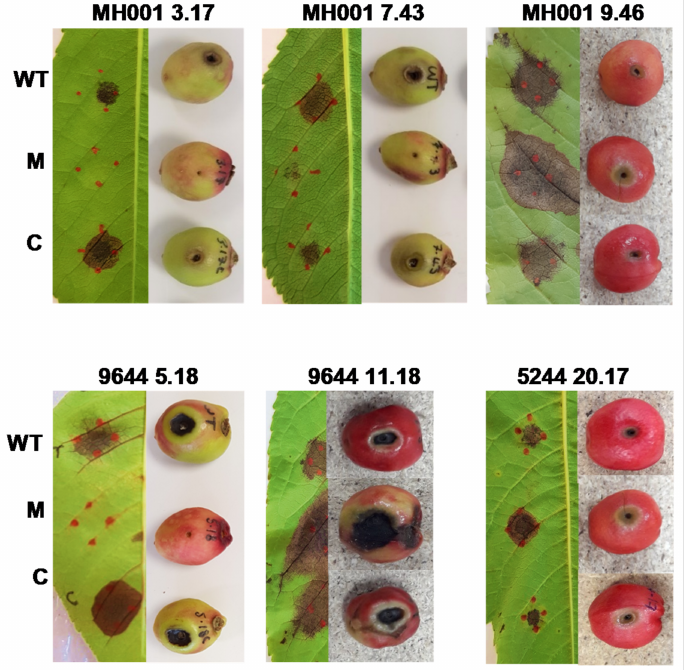
Figure 4. Complementation of selected Pseudomonas syringae transposon disruption mutants. Mutants that showed no disease symptoms (-) on cherry fruit but displayed wild-type (WT) characteristics in all other phenotypic assays, along with several mutants that displayed hypervirulence (+++) on cherry fruit were selected for complementation. The disrupted genes (3.17, dnaJ ; 7.43, hrcS ; 5.18, glycosyl transferase 1; 9.46, hopAU1 ; 11.18, nhaA ; 20.17, argE ) were cloned into a broad host range vector and transformed into their respective mutant strain. The WT, Tn mutant (M) and complemented strains © were tested on cherry fruit and cherry leaves to confirm restoration pathogeniciy in the complemented strains. Images displayed show 6 of the 18 complemented strains. However, in all cases, pathogenicity was restored on both fruit and leaves. Images of 9644—11.18 and 5244—20.17 are composites of three